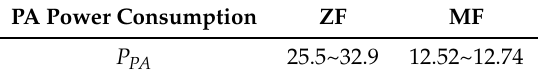
Table 3. J = 0 points for ZF and MF precoding.